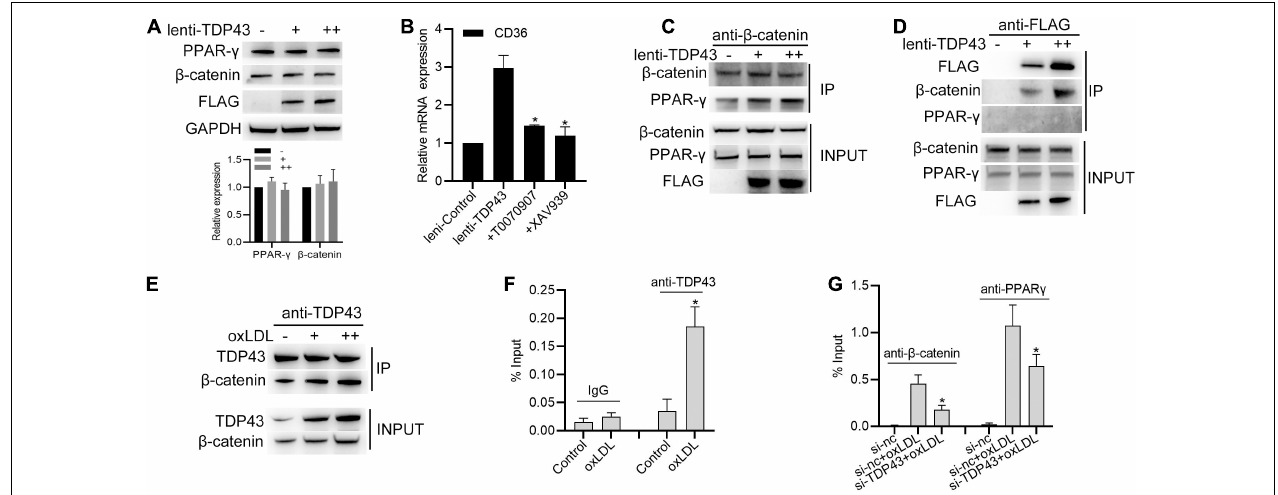
FIGURE 6 | Transactive response DNA-binding protein ∼ 43 kDa (TDP43) strengthens CD36 transcription by regulating β -catenin and PPAR- γ complex formation. (A) Western blot analysis of PPAR- γ and β -catenin protein expressions in macrophages infected with lenti-control or lenti-TDP43 for 48h. GAPDH was used as a loading control. (B) qPCR detection of CD36 mRNA in macrophages incubated with T0070907 (PPAR- γ inhibitor, 2 nM) or XAV939 ( β -catenin signaling inhibitor, 5 nM) and later infected with lenti-control or lenti-TDP43 for 48 h. Data are represented as means ± SD ( n = 3; * P < 0.05 vs. lenti-TDP43 group). (C) Co-IP analysis of the interaction between β -catenin and PPAR- γ in macrophages infected with lenti-control or lenti-TDP43 for 48 h. (D) Co-IP analysis of interactions among flag-tagged TDP43, β -catenin and PPAR- γ in macrophages infected with lenti-control or lenti-TDP43 for 48h by using FLAG antibody to specific precipitate FLAG-tagged TDP43 protein complex. Scale bar = 100 µ m. (E) Co-IP analysis of the interaction between β -catenin and TDP43 in macrophages infected with or without oxLDL (40 µ g/mL: +; 60 µ g/mL: ++) for 24 h using TDP43 antibody to specific precipitate TDP43 protein complex. Scale bar = 100 µ m. (F) ChIP analysis of the binding of TDP43 (IgG used as negative control) to CD36 promoter in macrophages with 40 µ g/mL oxLDL incubation for 24 h. Data are represented as means ± SD ( n = 3; * P < 0.05 vs. control group). (G) ChIP analysis of the binding of PPAR- γ or β -catenin to CD36 promoter in macrophages transfected with si-TDP43 or si-nc for 24 h and later incubated with 40 µ g/mL oxLDL for 24 h. Data are represented as means ± SD ( n = 3; * P < 0.05 vs. si-nc + oxLDL